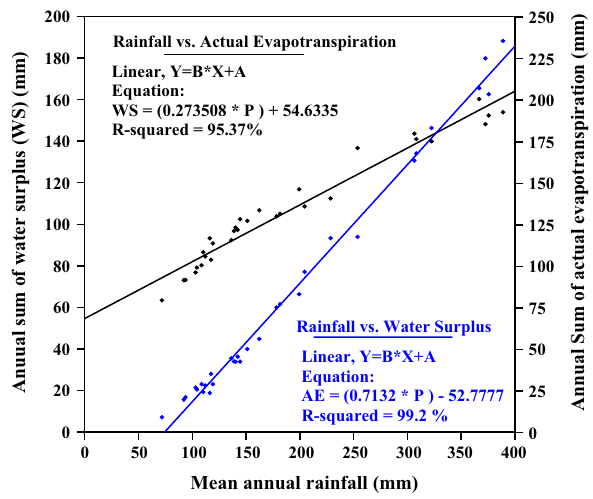
Fig. 5 The relationship of rainfall versus (WS) and